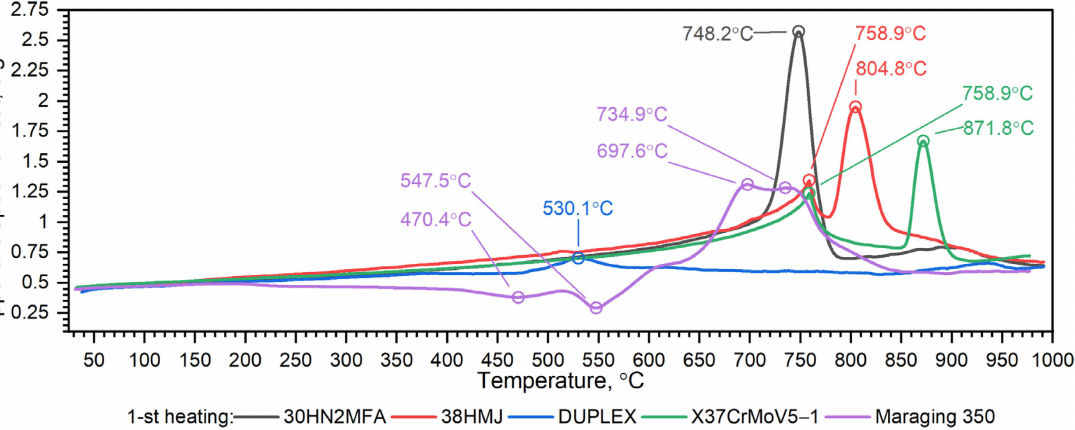
Figure 23. Comparison of apparent specific heat as a function of temperature for X37CrMoV5 − 1, Maraging 350, 38HMJ, 30HN2MFA and Duplex 2205 sheets of steel